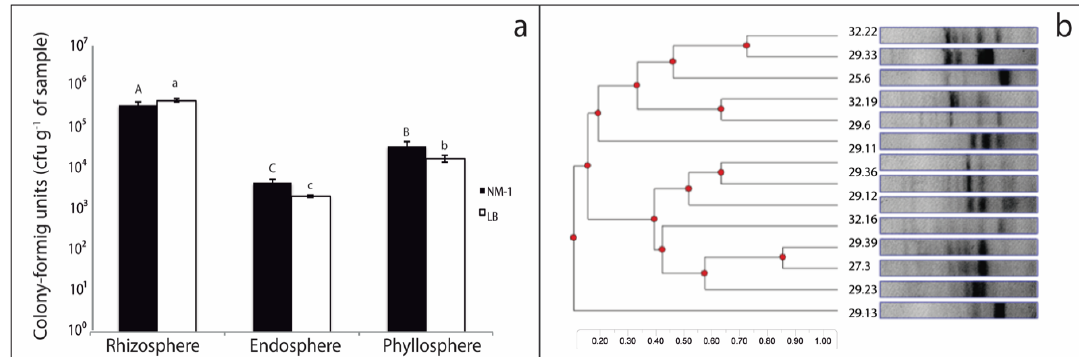
Figure 2. Counts of total heterotrophic bacteria ( a ) on NM-1 (light bars) and Luria-Bertani (LB) (solid bars) agar solidified medium for different plant niches. ( b ) Example of a dendrogram built using Phoretix 1D Pro gel analysis (TotalLab Ltd., Newcastle upon Tyne, UK) representing enterobacterial repetitive intergenic consensus polymerase chain reaction (ERIC-PCR) results and used to identify putative ACC-degrading bacteria with similar phenotypes but different genotypes. The bars represent standard error, and the same letter (uppercase for NM-1 or lowercase for LB) denotes no significant difference ( p ≤ 0.05, Tukey’s multiple range test).